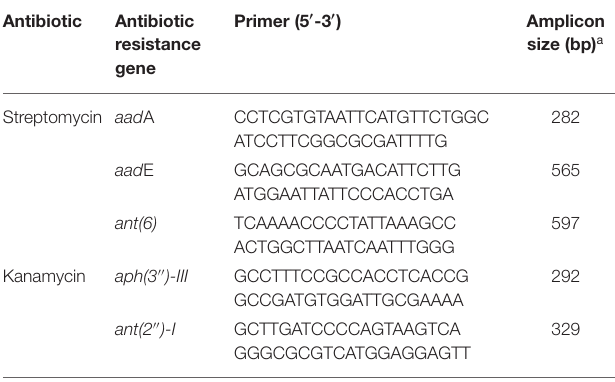
TABLE 2 | Primers used for PCR detection of antibiotic-resistance